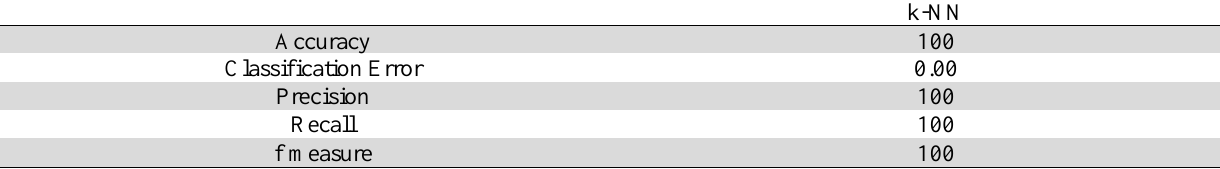
Model performance criteria